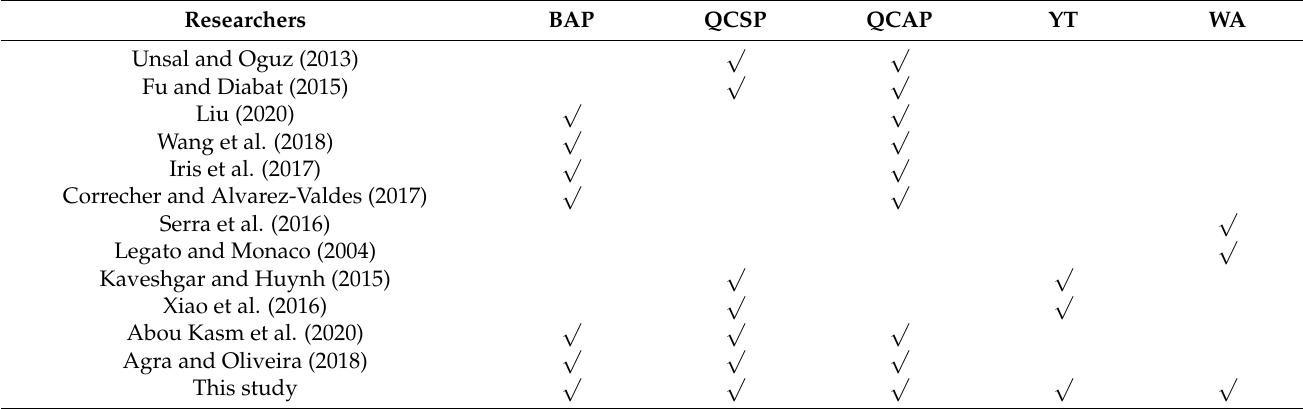
Table 1. Summary of the literature